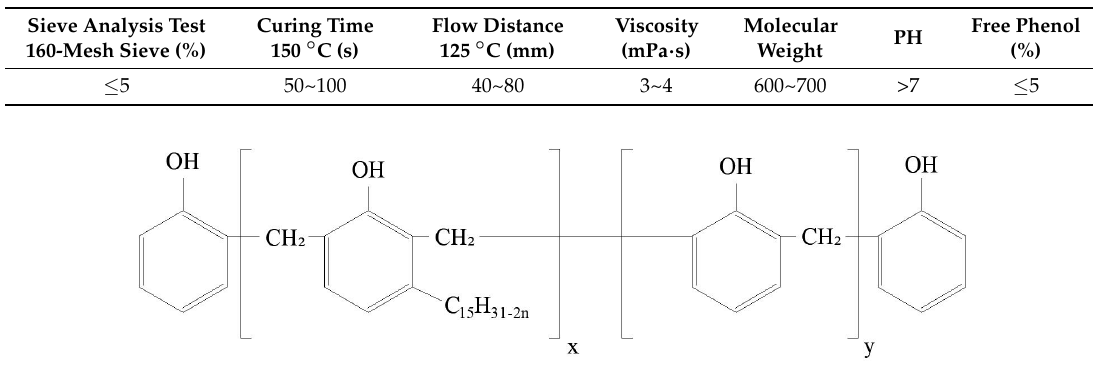
Table 2. The technical index of resin used in composites.